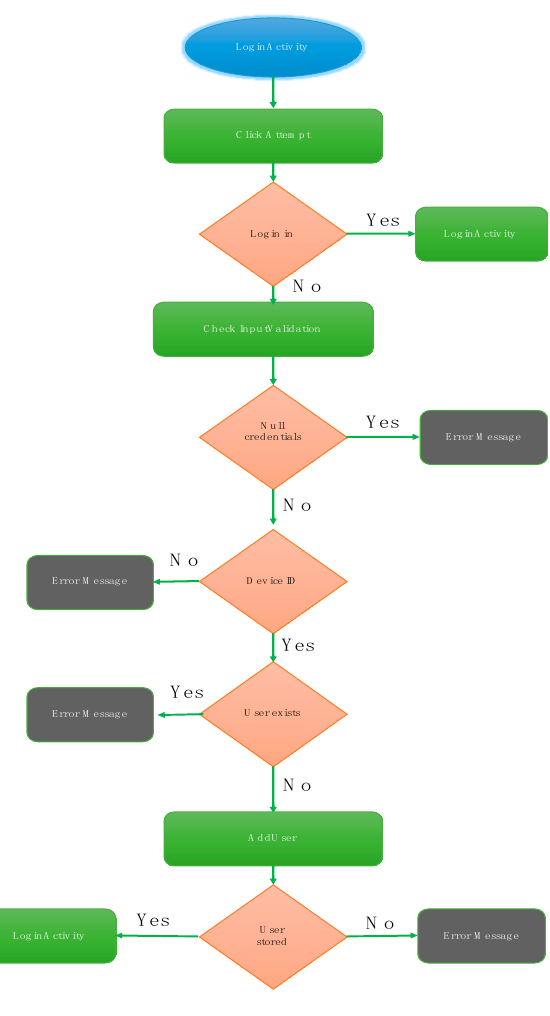
Figure 14. User register flow-chart.